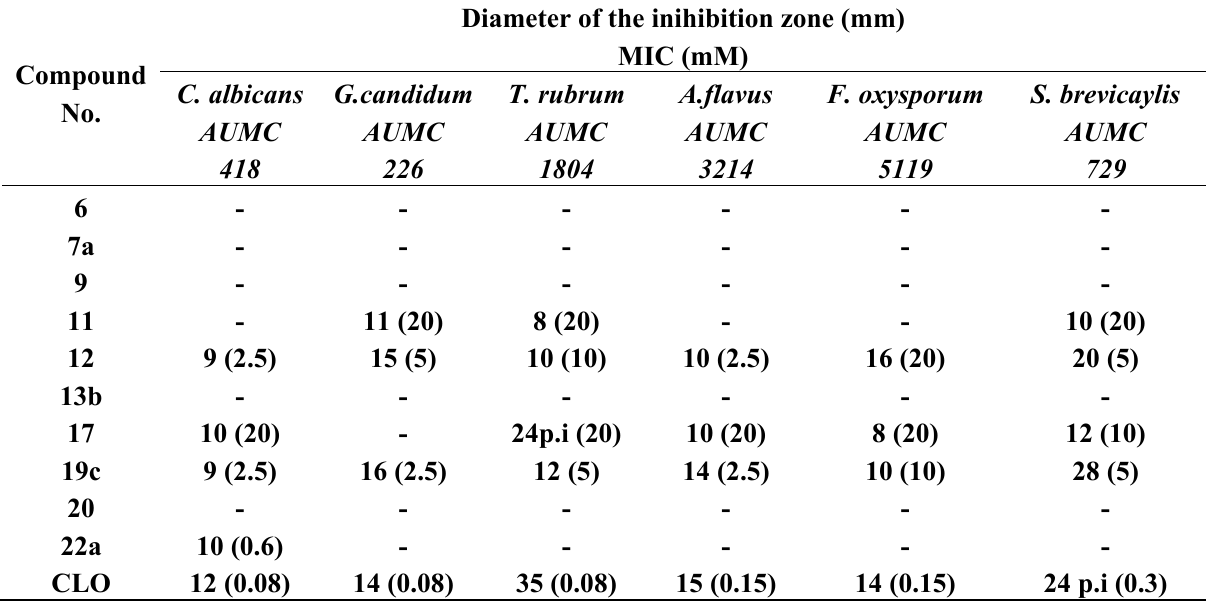
Table 2. Antifungal activity data [inhibition zone in mm/ MICs (in